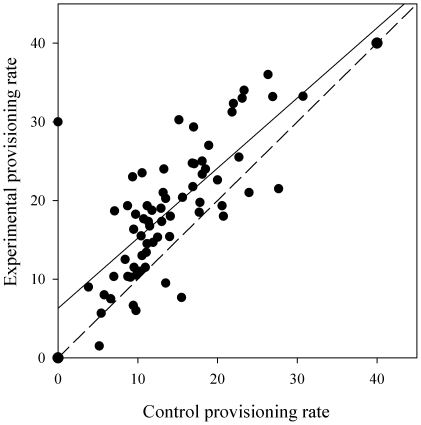
Manipulated individual provisioning rates plotted against control individual provisioning rates.Each circle represents a single individual. The solid line shows the regression slope through the actual data (y = 0.89x+6.18) while the dashed line shows the relationship expected if there were no effect of manipulation. As brood sizes were increased by 33%, a gradient of 1.33 would represent a proportional increase in effort, relative to the control feeding rate. Whereas a gradient of 1 with an intercept greater than zero would show a constant increase in feeding rate in response to the manipulation (N = 65).